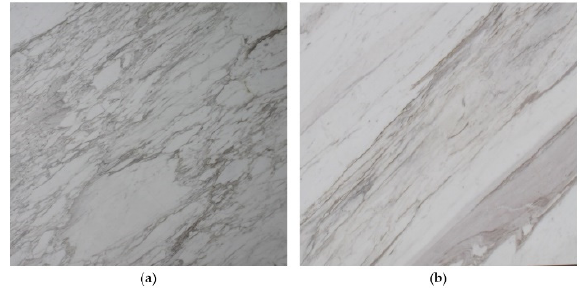
Figure 1. Main marble vein types: type L ( a ), and type D ( b ).